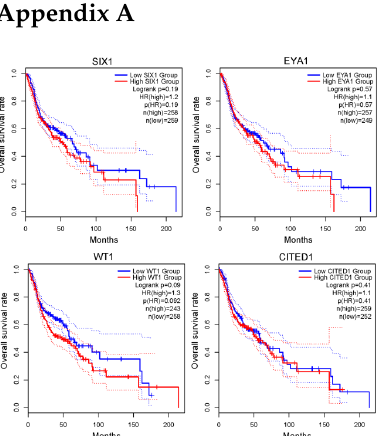
Figure A1. The relationship between the interacted genes and overall survival of patients with head and neck carcinoma derived from TCGA (SIX1 represents the SIX family, and there were no data regarding PAX2 and SALL1 in head and neck carcinoma).